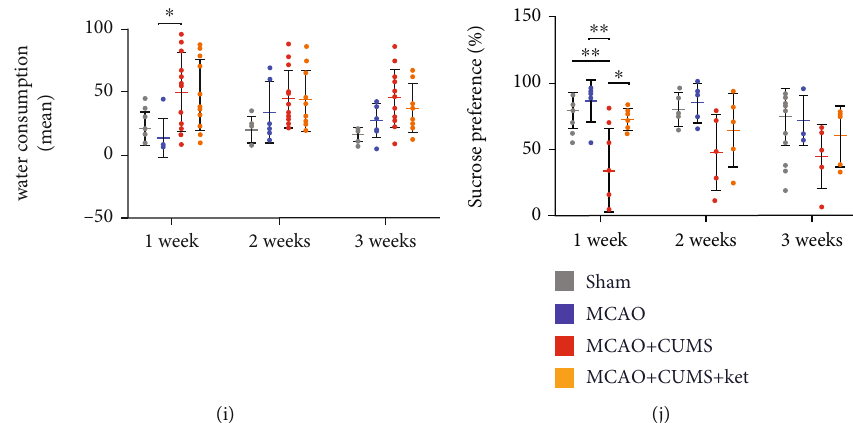
Figure 2: E ff ects of ketamine on the behaviors of depressive-like MCAO rats. (a) Comparison of the immobility duration of the study groups after ketamine administration (OFT). (b) Representative movement tracks of di ff erent groups (OFT). (c) Rearing counts of various groups after ketamine treatment. (d) Changes in distance travelled after ketamine treatment. (e) Temporal improvements in average speed after ketamine administration. (f) Variations in explorative time spent in the central zone of each group. (g) Variations in time spent in the corner zone after ketamine treatment. (h) Changes in sucrose consumption after ketamine administration (SPT). (i) Di ff erences in water consumption between groups at various time points. (j) Temporal variations in sucrose intake preference after ketamine treatment. 1w: 1 week. One-way ANOVA followed by Tukey ’ s multiple comparison tests. n = 16 per group. ∗ p < 0 : 05 , ∗∗ p < 0 : 005 , ∗∗∗ p < 0 : 0005 , and ∗∗∗∗ p < 0 : 0001